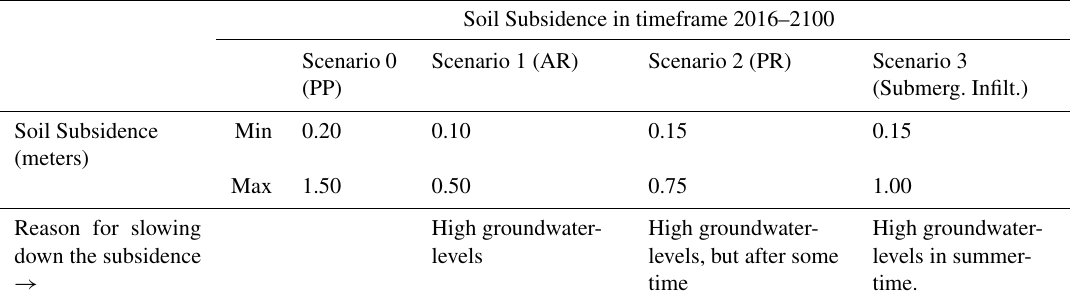
Table 3. Soil subsidence in the 4 analyzed scenarios.